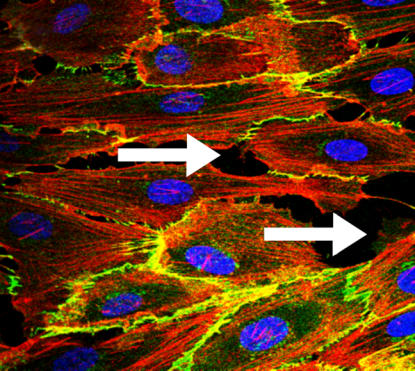
Ang-2 causes intercellular gaps in cultured endothelial cells